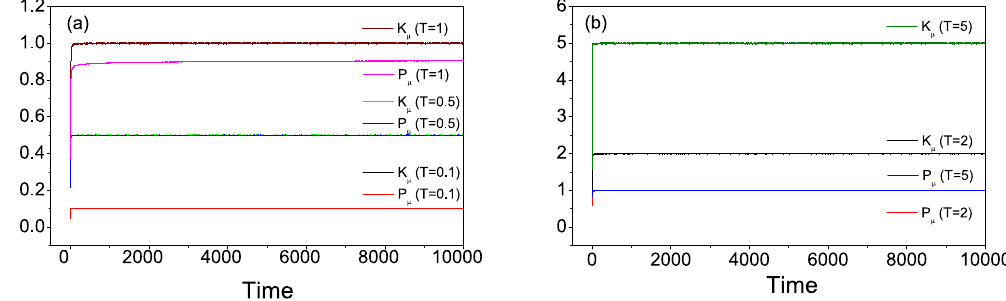
Figure 4. K μ and P μ as function of the evolution time for different Langevin thermostat’s temperature T . For a given time, K μ and P μ are calculated by ensemble average. Here τ = 1, ε = 0.0001, γ = 0.7, and the number of ensembles is 1 × 10 6 .